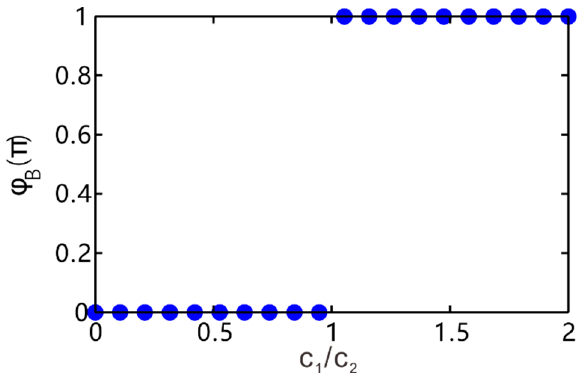
Figure 2. The Berry phase as a function of the ratio of relative coupling strength. The Berry phase of two band structures is equal, which is 0 as c 2 > c 1 and π as c 2 < c 1 .